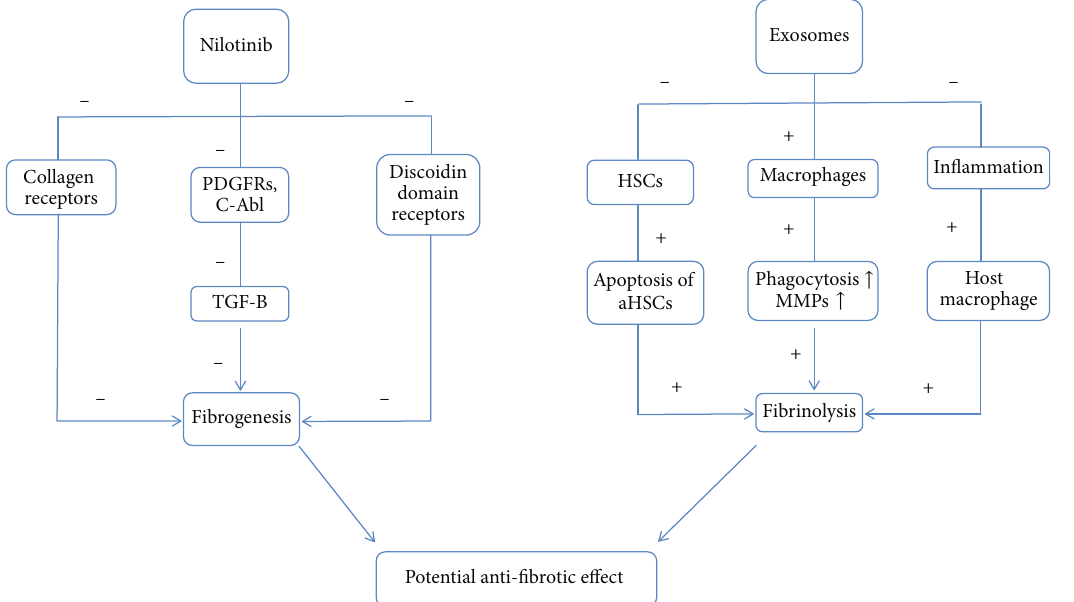
Figure 5: Potential synergetic anti fi brotic e ff ect of MSC-MC and Nilotinib